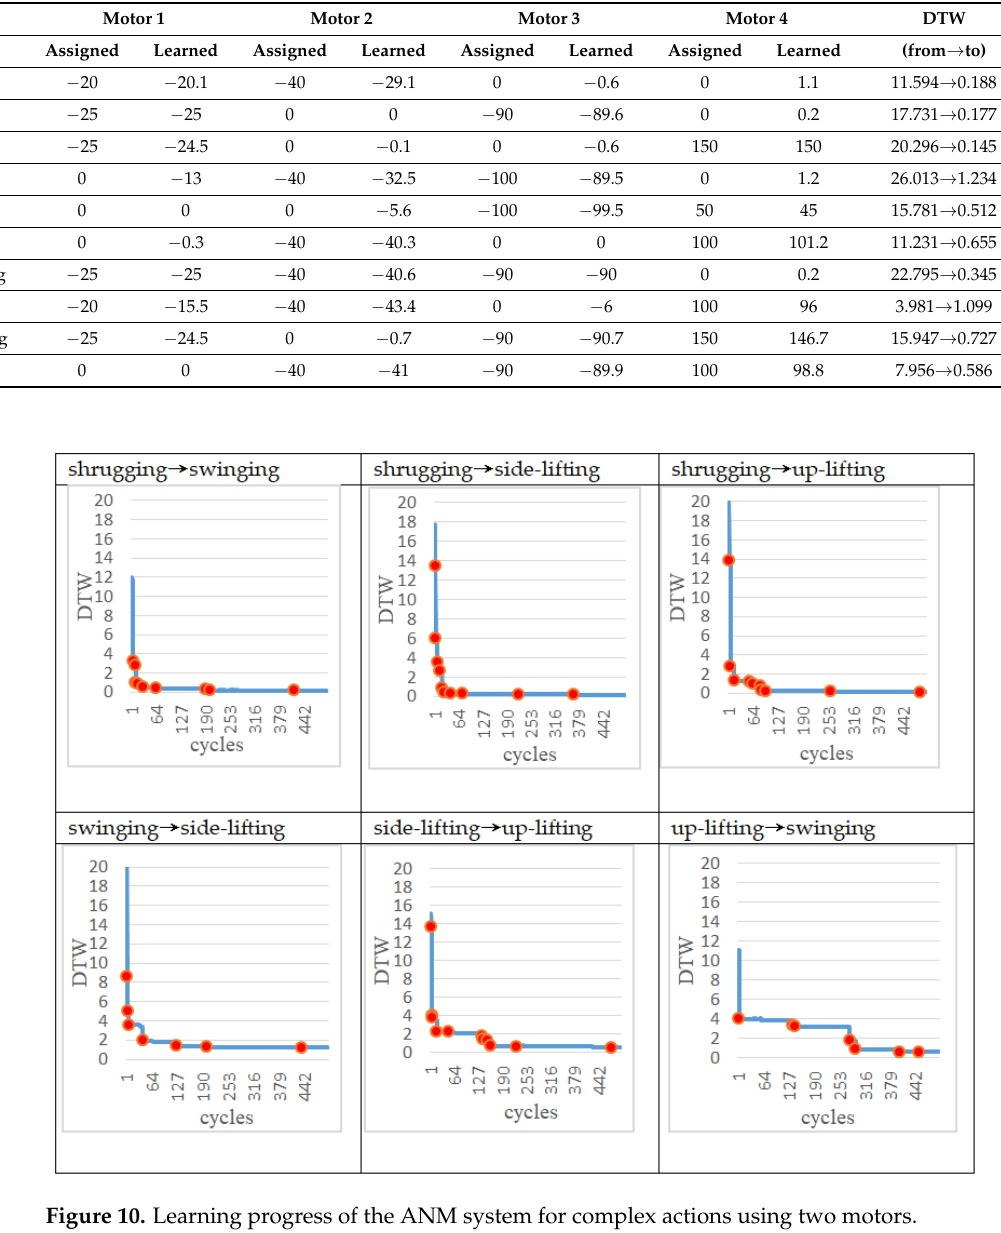
Table 2. The experimental results of multi-motor actions.